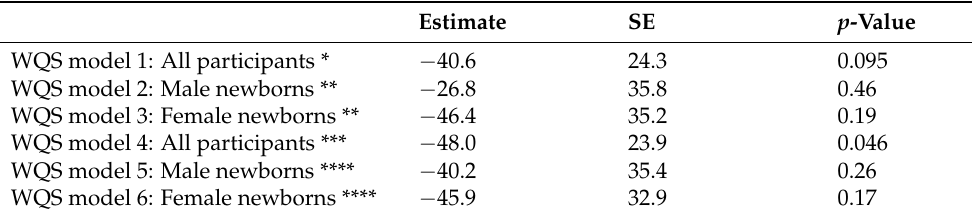
Table 3. Coefficients (estimate), standard error, and p -values from weighted quantile sum regression models for all participants and their